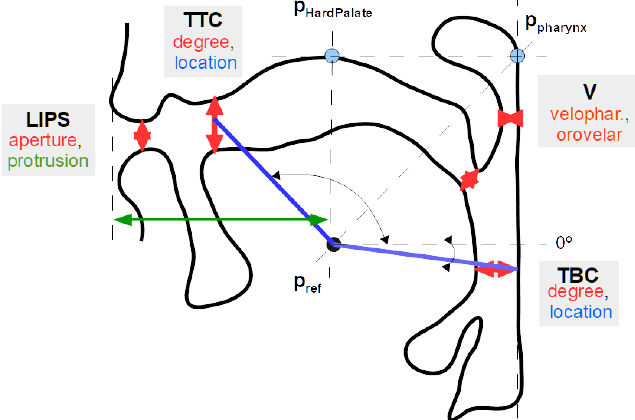
Figure 5. Illustrative vocal tract representation depicting the main aspects of the considered tract variables: tongue tip constriction (TTC, defined by degree and location); tongue body constriction (TBC, defined by degree and location), computed considering both the pharyngeal wall and hard palate; velum (V, defined by the extent of the velopharyngeal and orovelar passages); and lips (LIPS, defined by aperture and protrusion). The point p ref is used as a reference for computing constriction angular locations. Please refer to the text for further